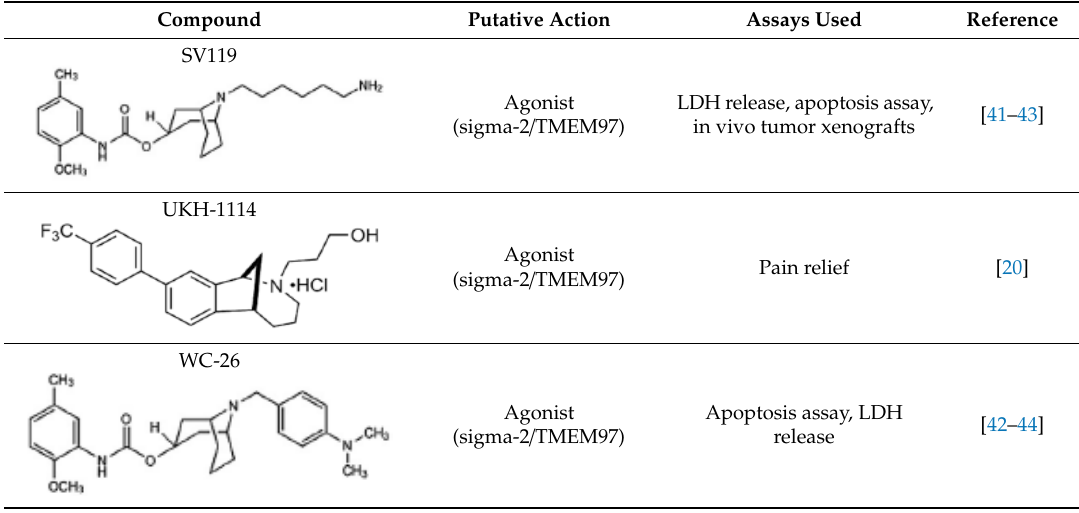
(Figure 2). In addition to SREBP2, liver X receptors (LXRs) [48,49] and nuclear factor erythroid 2 related factor-1 (NRF1) [50] are also involved in the regulation of cholesterol synthesis. High cholesterol levels activate LXRs, resulting in cholesterol synthesis inhibition